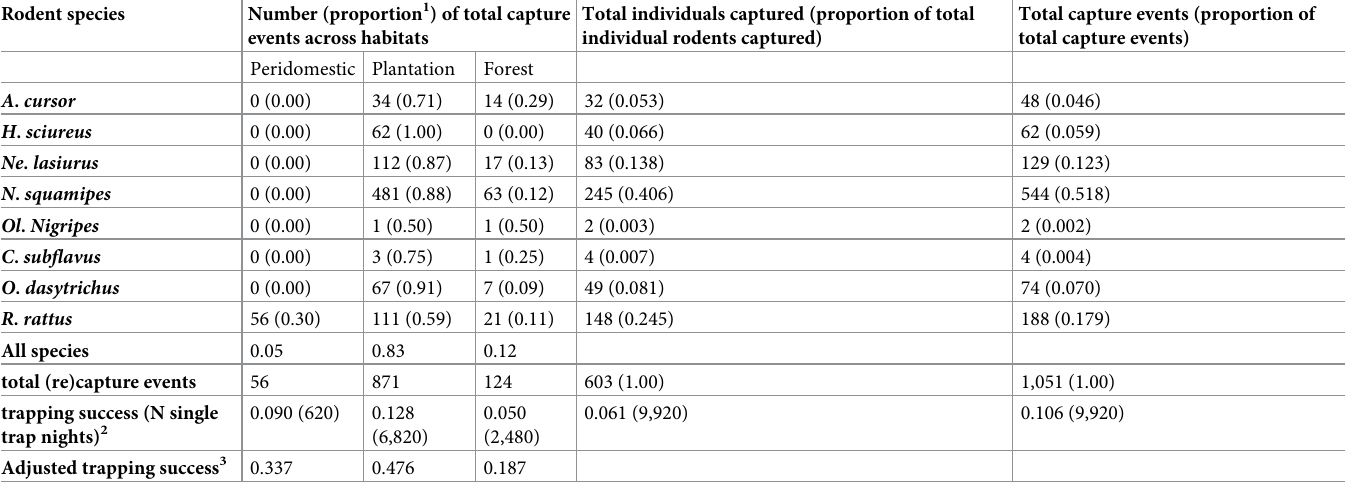
Table 1. Rodent trapping success: number and proportion of total (re)capture events across sampled ecotypes. Rodent species Number (proportion 1 ) of total capture Total individuals captured (proportion of total events across habitats individual rodents captured)